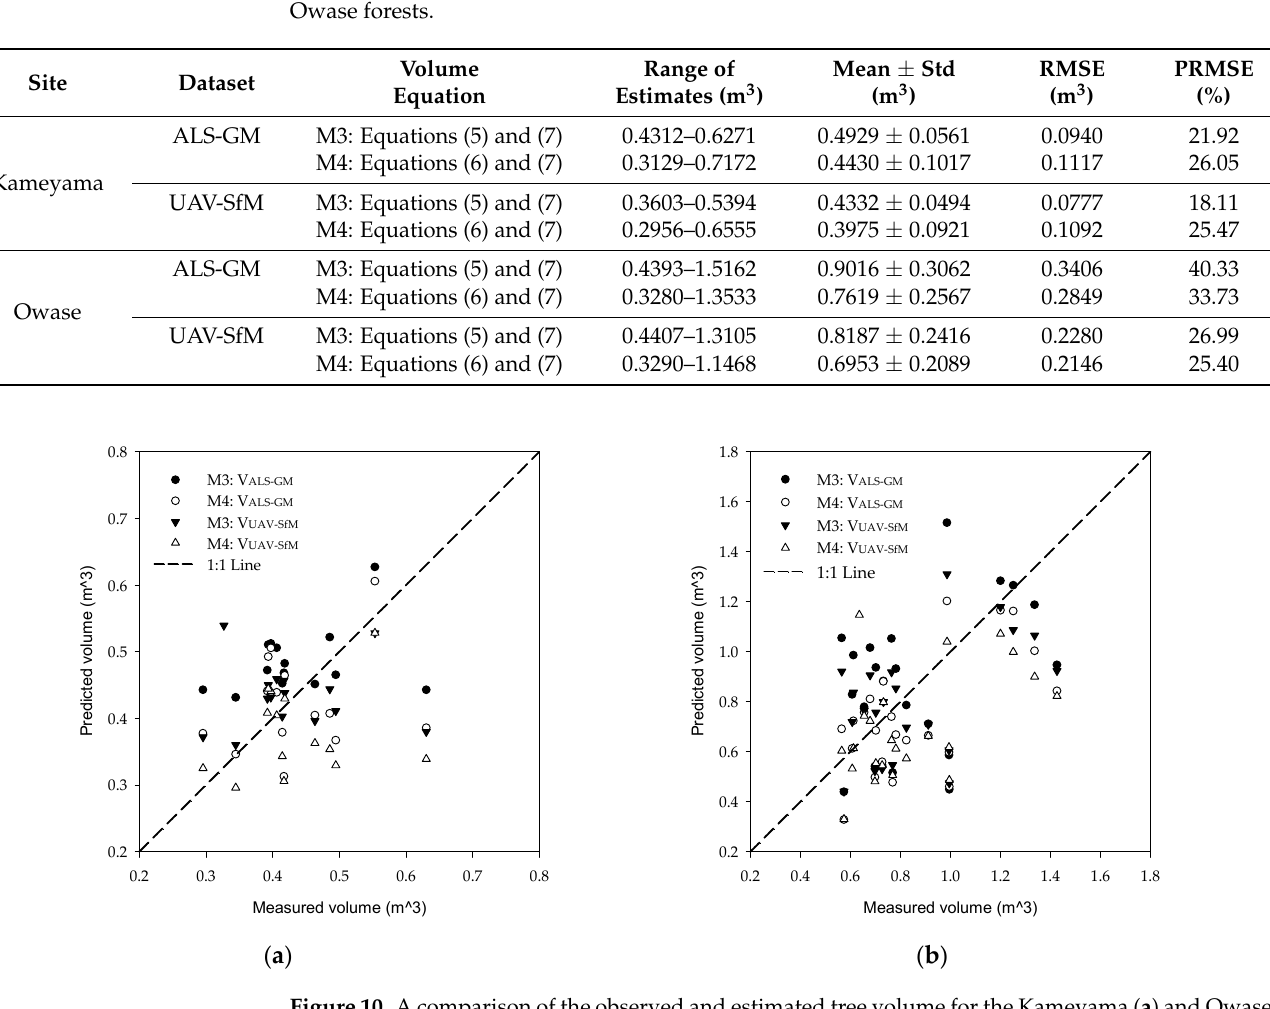
Table 7. Summary of the tree volume estimation and accuracy evaluation for the Kameyama and Owase forests.